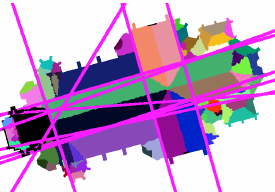
Figure 10: A Hough-transform determines step lines going through step edges in the interior of the ground